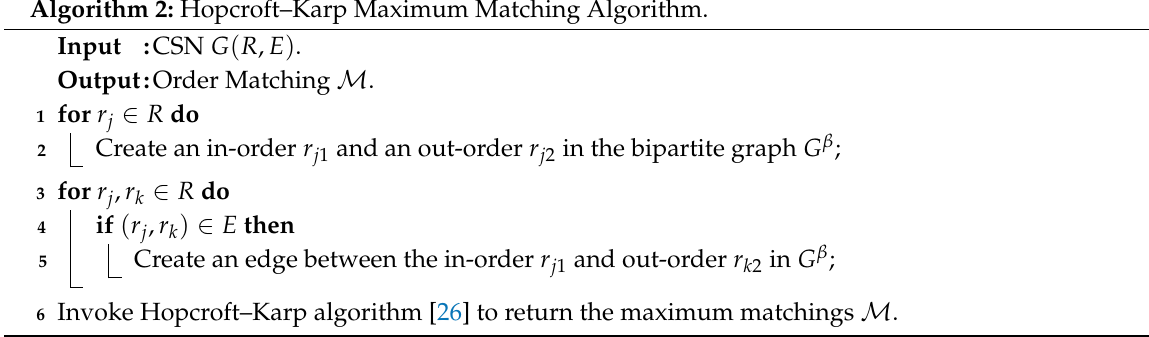
Algorithm 2: Hopcroft–Karp Maximum Matching